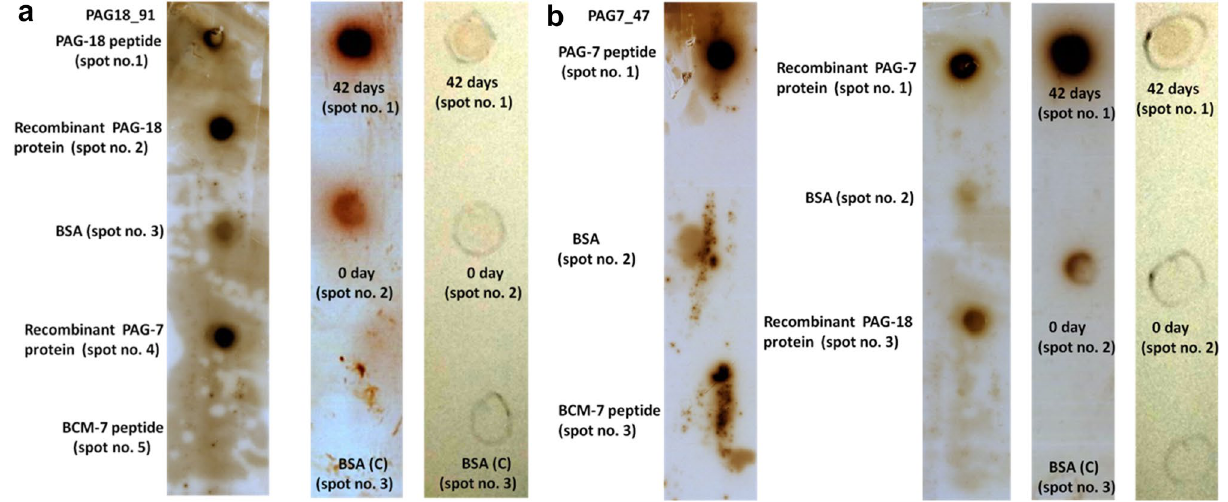
Figure 14. Detection of PAG-18 ( a ) and 7 ( b ) proteins by aptamers in ECL and DAB coloring